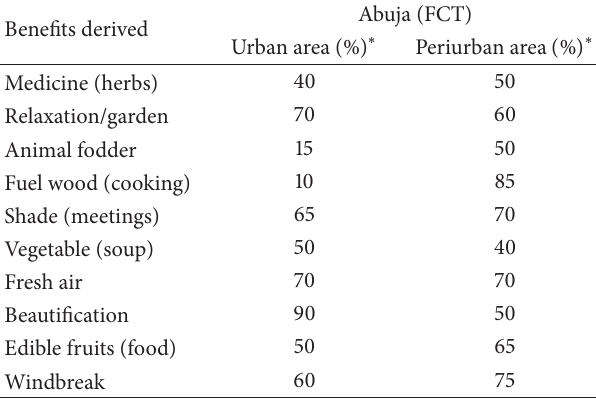
Table 4: Benefits derived by respondents (%) from urban and periurban forests in the Federal Capital Territory,